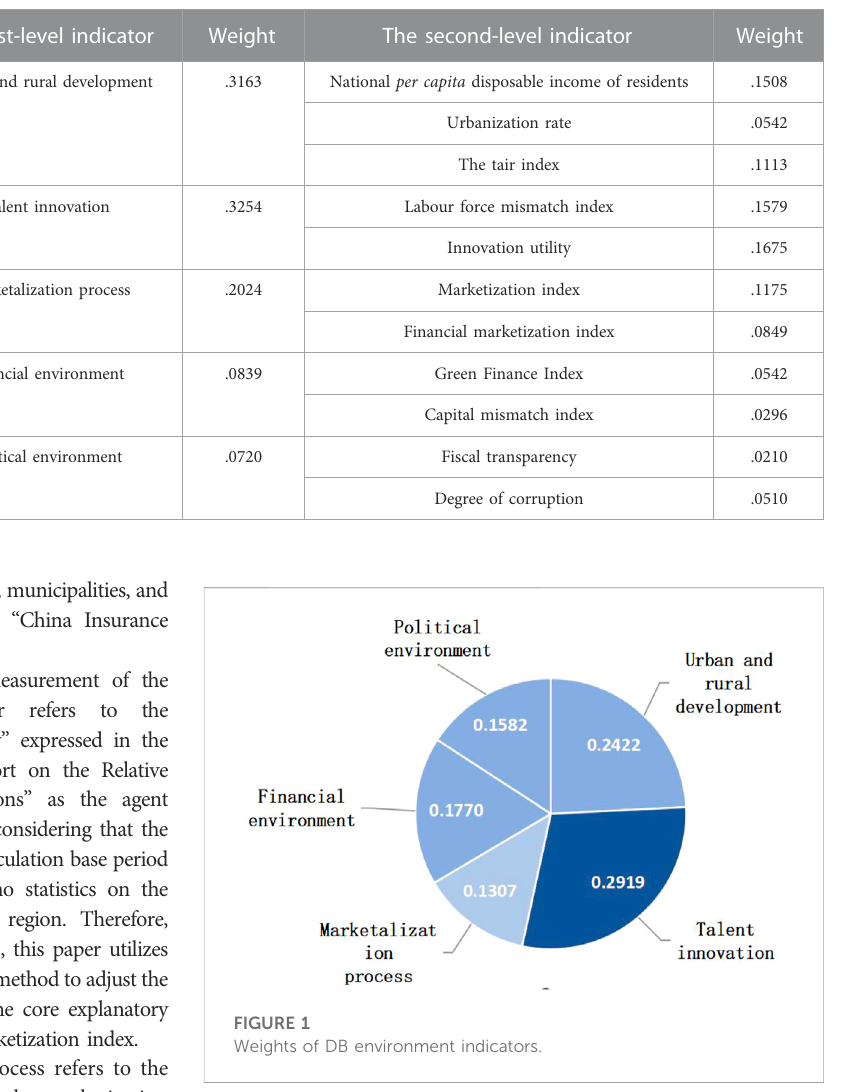
TABLE 2 The weight of the indicators.